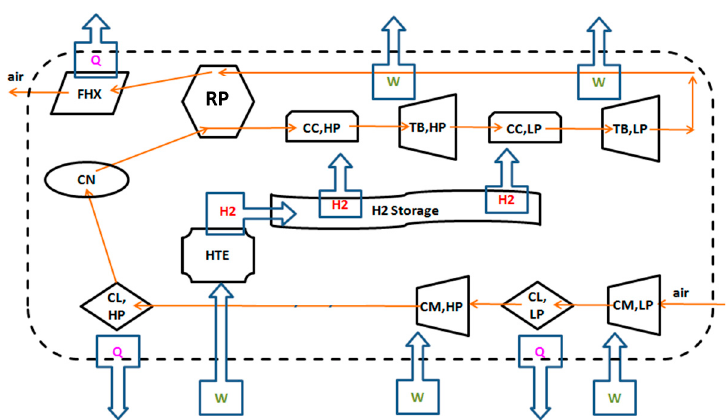
Figure 5. Schematic of the CAES-HTE system simulated. HTE stands for high temperature electrolyzer. “Q” and “W” represent heat and work interactions between the system and the surroundings. The air leaving the cavern is preheated in the recuperator by the hot air leaving the low pressure turbine (internal heat transfer). The air leaving the high pressure compressor provides the heat demand of the HTE (internal heat transfer).